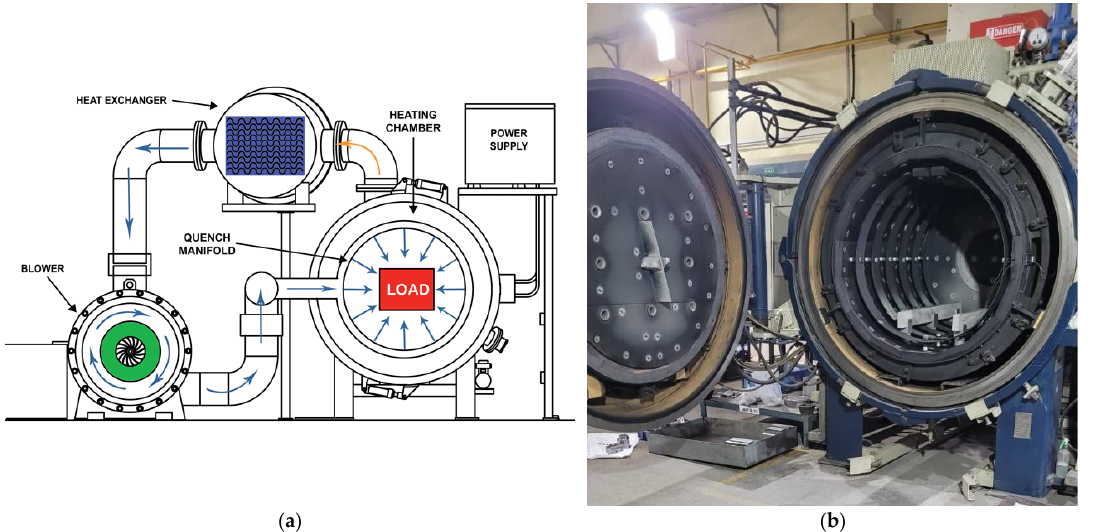
Figure 1. ( a ) Block Diagram of vacuum heat treatment method; ( b ) Actual photo of vacuum heat treatment chamber.